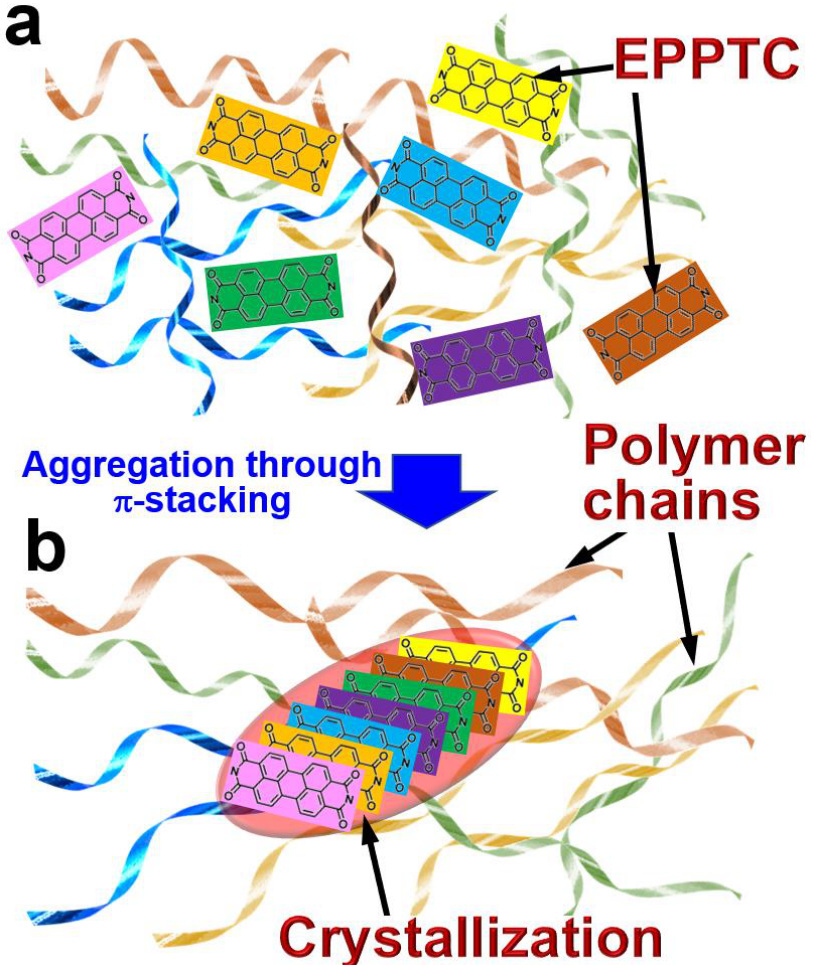
Figure 1. ( a ) Distribution of the EPPTC molecules in the solid film of PMMA molecular chains. ( b ) Crystallization of EPPTC small molecules due to their motion across the annealing-flexibilized PMMA molecular chains.